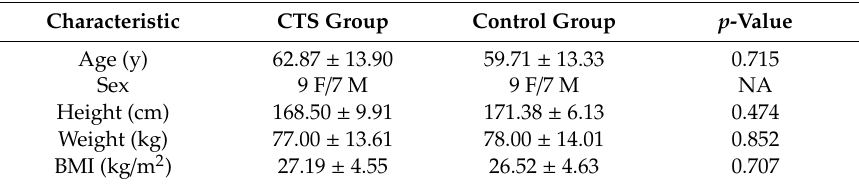
Table 1. Participant